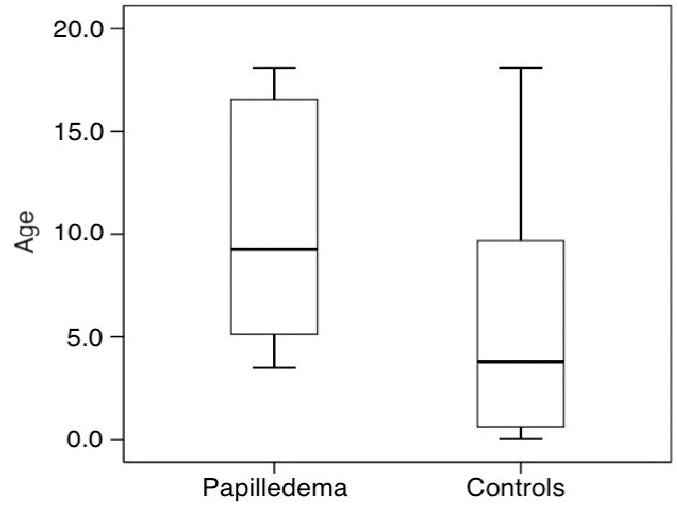
Figure 1. Box plot graph showing statistically significant correlation between papilledema and age. Table 7. Comparison of ICP values according to the primary